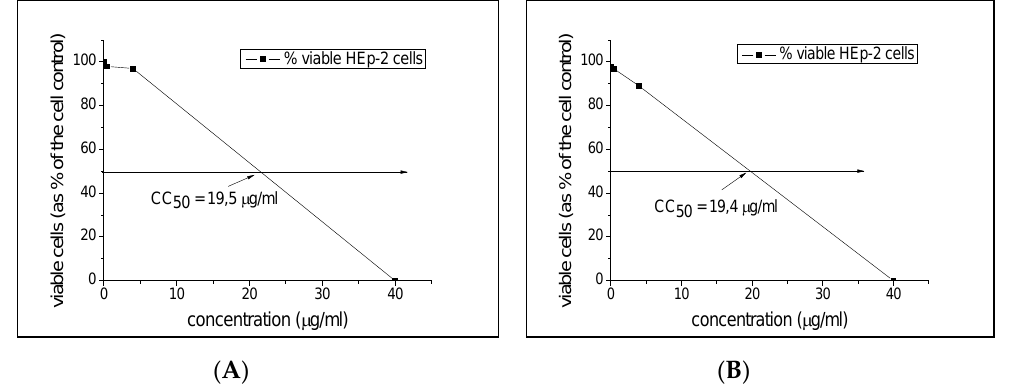
Figure 7. Cytotoxicity values of the compounds ACR ( A ), and [Cu 2 (ACR)(NO 3 ) 2 ] ( B ) towards HEp-2 cells.